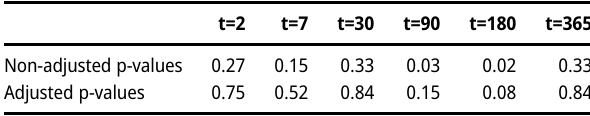
Table  : Test comparison between AUCROC for MELD-Na and AMELD.